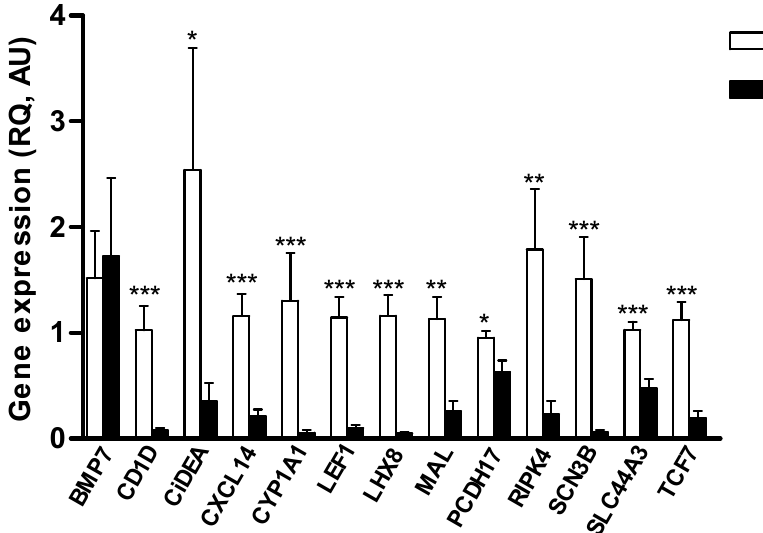
Figure 2. Gene expression of 13 candidate TSGs in cDLBCLs and control LNs. The mRNA expression was evaluated by qPCR in 12 cDLBCL and 10 LN samples. The relative expression values (RQ) are expressed in arbitrary units (AU), as the mean ± SEM. Statistical analysis: Mann Whitney test. *: p < 0.05; **: p < 0.01; ***: p < 0.001.